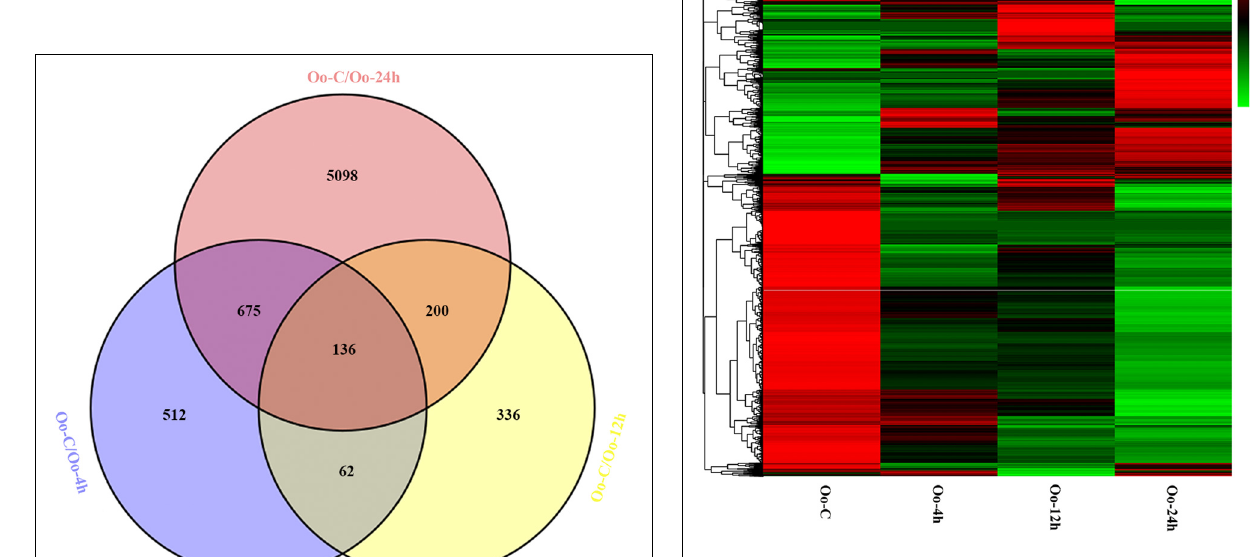
FIGURE 3 | Heatmap analysis of hierarchical clustering of DEGs at four time points. Each row represents one gene, and each column stands for a time point. The colors range from green to red, indicating the level of expression from low to